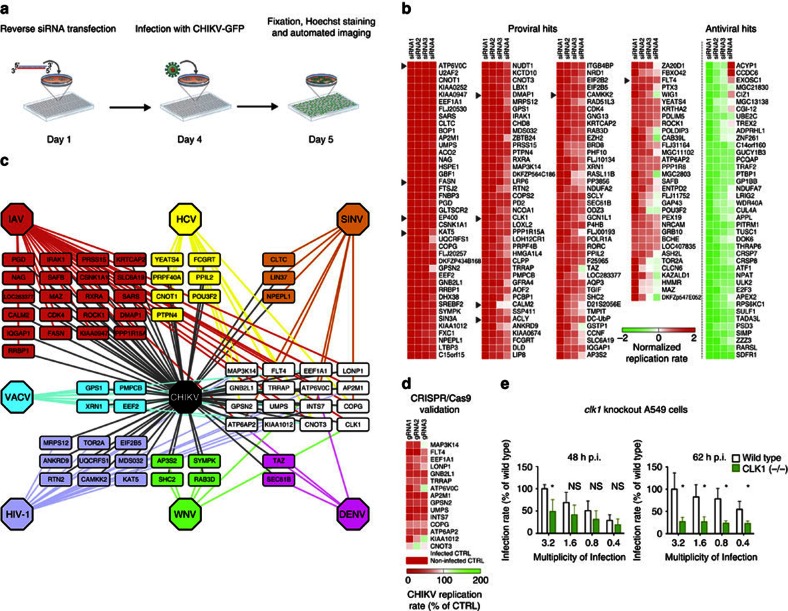
Primary screen for CHIKV host cell factors.(a) Outline of screening procedure. (b) Heatmap of all identified proviral and antiviral hits showing replication data (Z-scores) of the four most efficient siRNAs. Arrowheads indicate genes experimentally characterized in this study. (c) Requirement of identified proviral factors for other viruses based on published loss-of-function studies. Viruses other than CHIKV are indicated by specific colours, and colour-coded boxes contain genes shared between CHIKV and the corresponding virus. White boxes contain genes shared between CHIKV and more than one other virus. Full details in Supplementary Data 3. (d) Heatmap illustrating the replication capability of CHIKV in Cas9-positive HEK-293T cells expressing the indicated gRNAs. Cells were infected with CHIK-GFP at MOI 6 for 24 h (n=9). (e) Validation of CLK1 as CHIKV relevant host factor. Infection rate of A549 cells depleted for CLK1 by CRISPR/Cas9 (see Supplementary Fig. 1j for more details) and infected with CHIKV-GFP for the indicated periods of time (n=9 for each data set). Data represent the means±s.e.m. of three independent experiments and were analysed using one-way analysis of variance with Tukey's post test. (*P<0.05; NSP≥0.05). CTRL, control; NS, not significant.